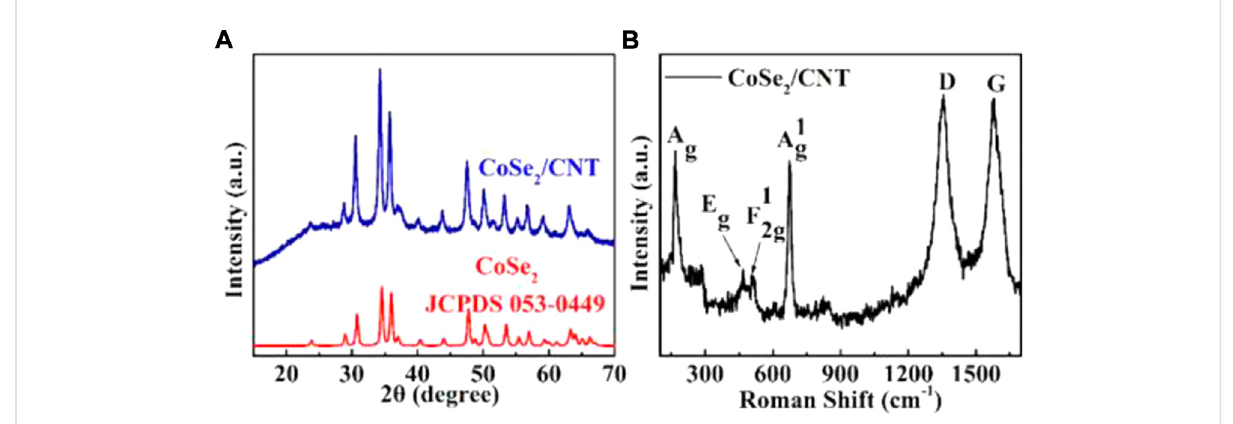
FIGURE 1 (A) XRD patterns and (B) Raman image of CoSe2/CNTs